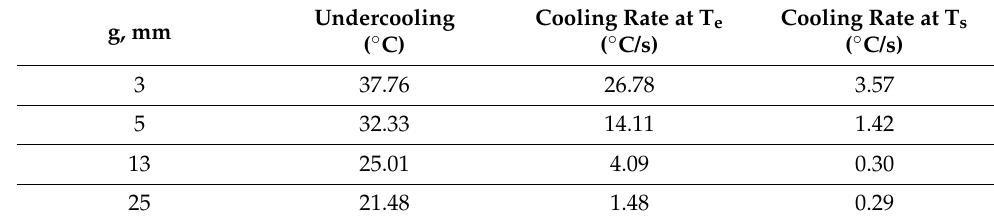
Table 2. Undercooling and cooling rates at eutectic and eutectoid transformation temperatures. g,